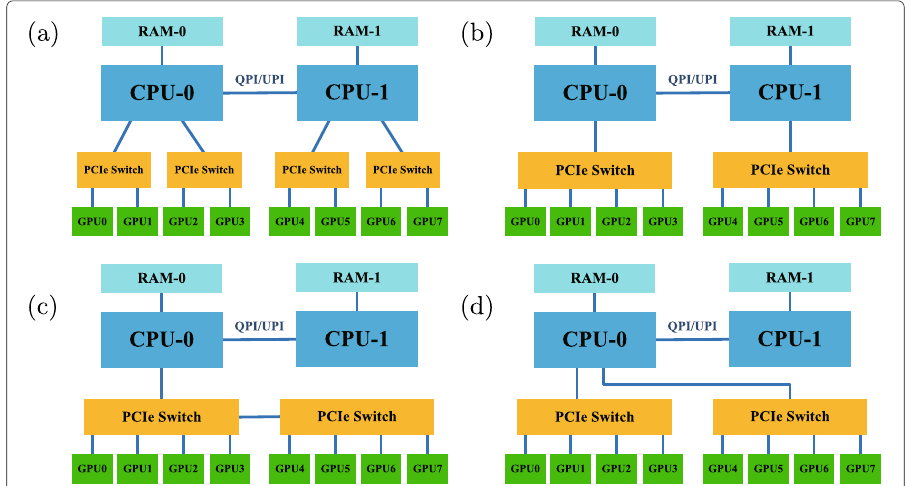
Fig. 6 Several typical PCIe root architectures of GPU server. For type ( a ), each NUMA node has a PCIe switch attached on them, and there are two GPUs mounted on each PCIe switch. For type ( b ), only one PCIe